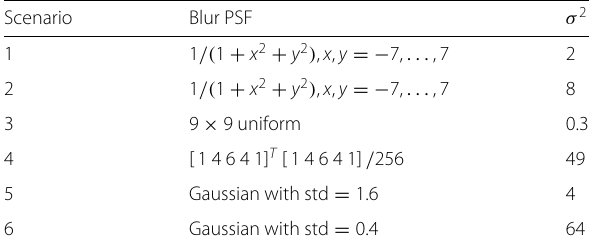
Table 1 PSF and noise variation for each scenario Scenario